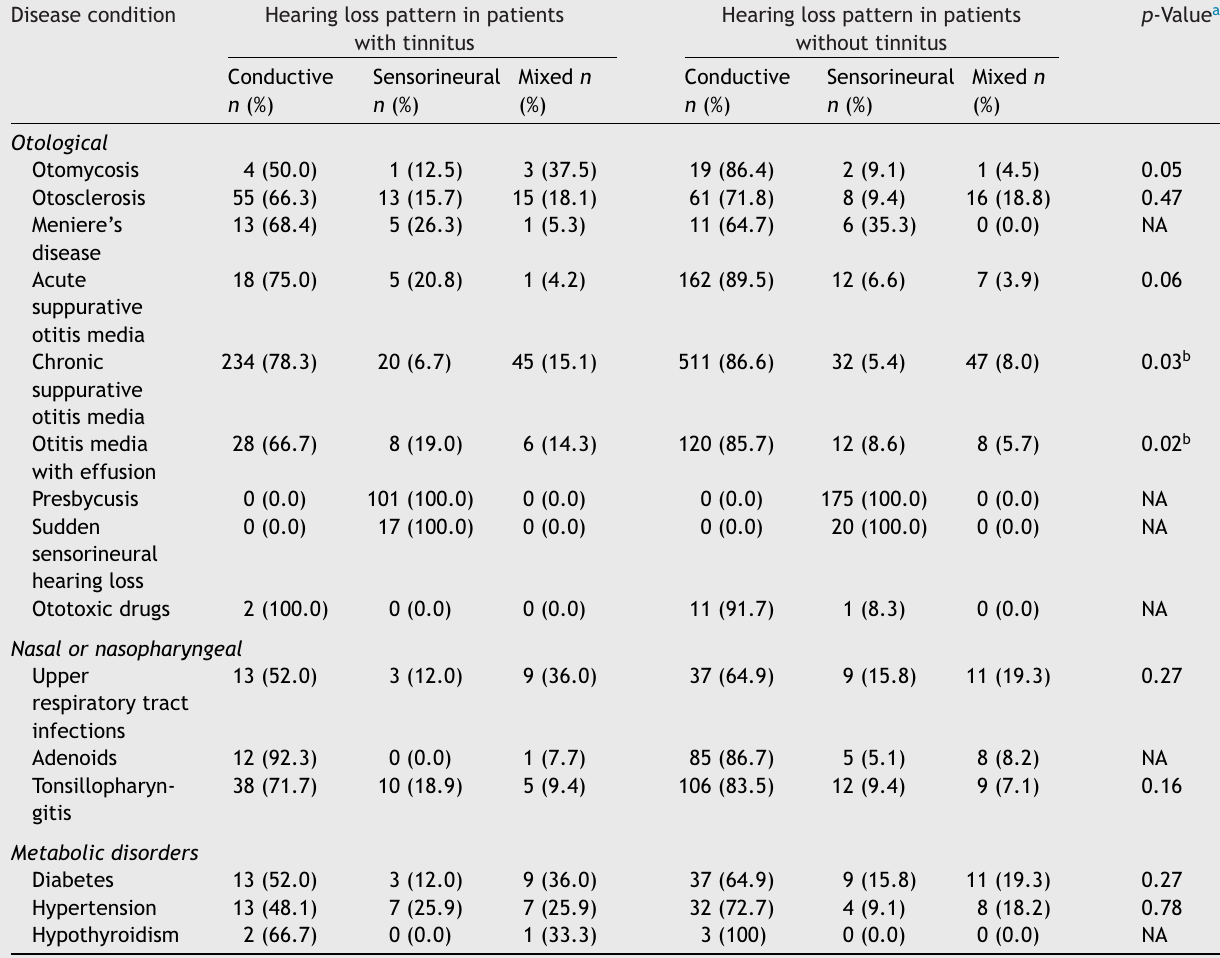
Table 3 Pattern of hearing loss in subjects with and without tinnitus in otological disorders. Disease condition Hearing loss pattern in patients Hearing loss pattern in with tinnitus